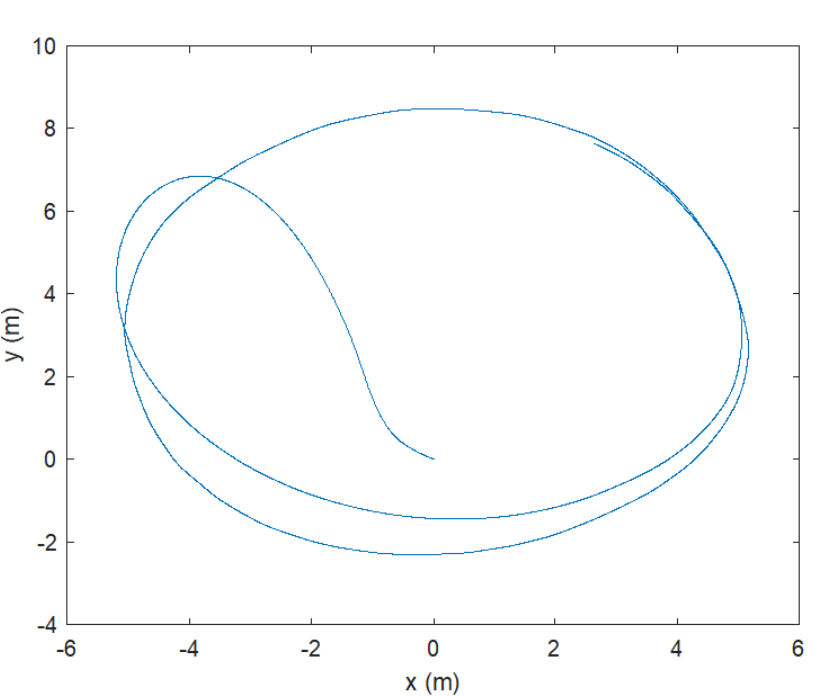
Figure 21. Multiplication fault: the 2D position control